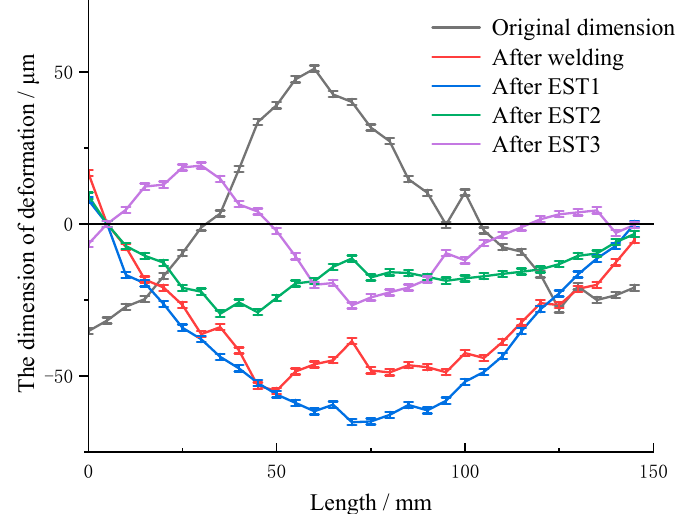
Figure 12. Levelness changes at the bottom of the A-pillar.